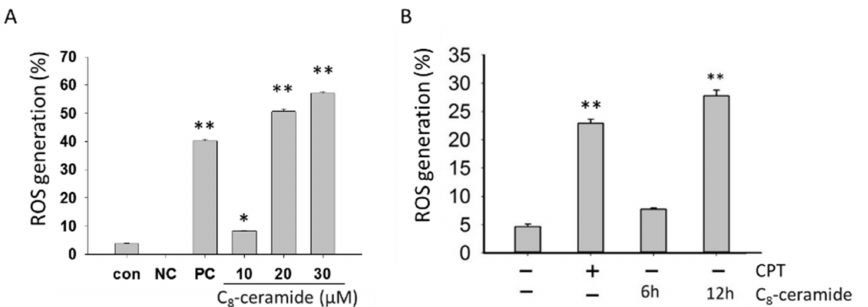
Figure 4. C 8 -ceramide increases the level of ROS in H1299 cells. ( A ) Flow cytometry-based ROS assessment for C 8 -ceramide-treated cells. Cells were treated with indicated concentrations (from 0 to 30 µ M) of C 8 -ceramide for 24 h respectively. Positive % was indicated in each panel. PC: positive control, 1 mM H 2 O 2 . CON: vehicle control. NC: negative control, unstained cells. Quantitative analysis. Data presented as mean ± S.D. in triplicate. Asterisks indicated statistically significant differences compared with those of the control (* p < 0.05 and ** p < 0.001 for control versus C 8 -ceramide treatment respectively). ( B ) The quantitative analysis. Data presented as mean ± S.D. in triplicates. Five µ M of camptothecin (CPT) as a positive control. Asterisks indicated statistically significant differences compared with those of the control (** p < 0.001 for C 8 -ceramide treatment versus respective control in 6 and 12 h).